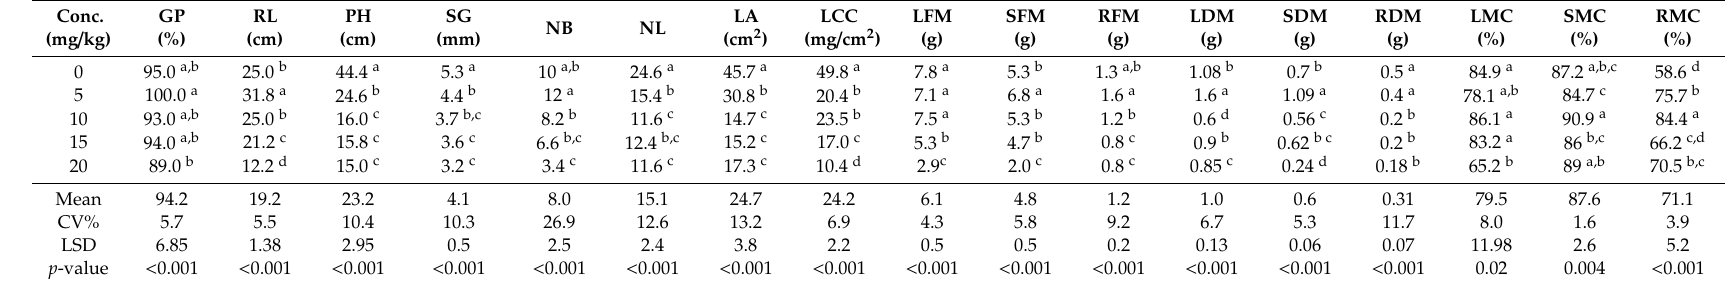
Table 1. E ff ect of cadmium in the vegetative traits of Corchorus